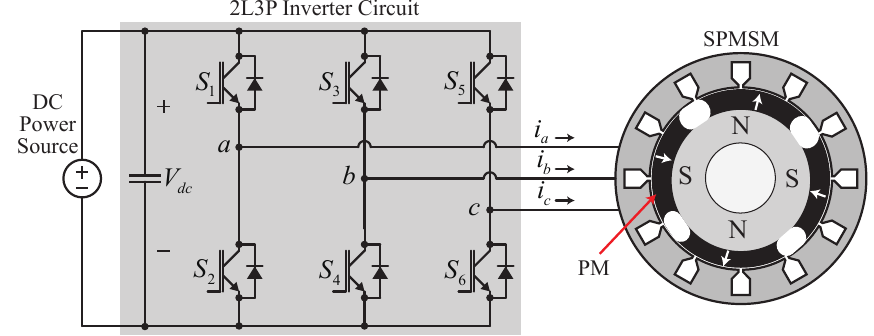
Figure 1. SPMSM powered by the 2L3P PWM